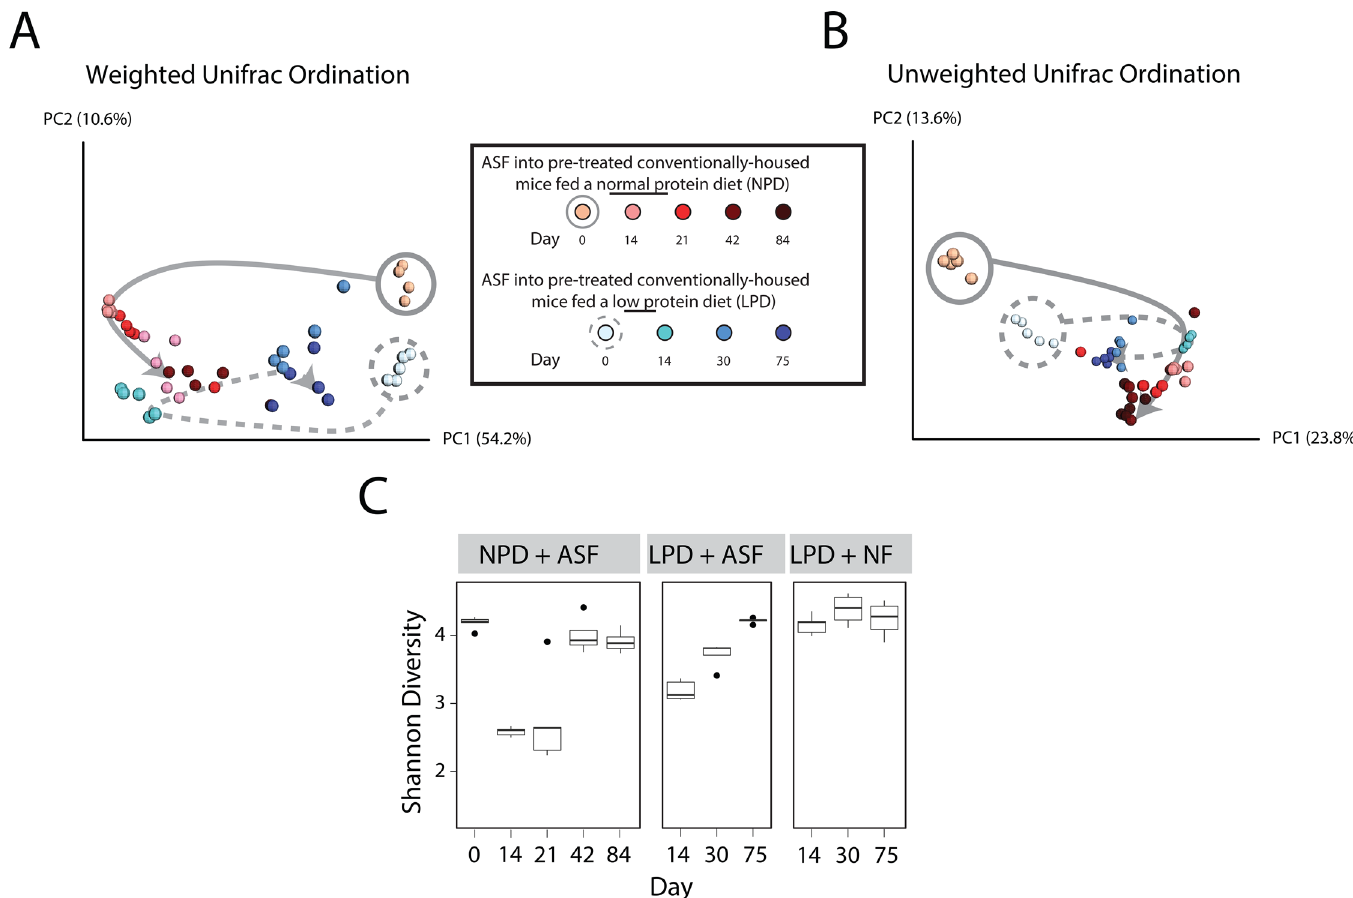
Fig 3. Effect of a LPD on the initial colonization of ASF and subsequent resilience over time. Principal coordinates analysis (PCoA) ordination of mice after transplantation with ASF. Changes in community membership were analyzed using (A) weighted and (B) unweighted Unifrac. Dietary groups are color coded as indicated with the shades of colors indicating progression in time. Day 0 samples have gray circles around them (solid for NPD, dashed for LPD). The arrows were added to help visualize the progression of time after ASF transplantation. (C) The interquartile range of Shannon diversity values are shown for mice on the NPD and LPD inoculated with either ASF or Normal Feces (NF). Black circles mark the outlier